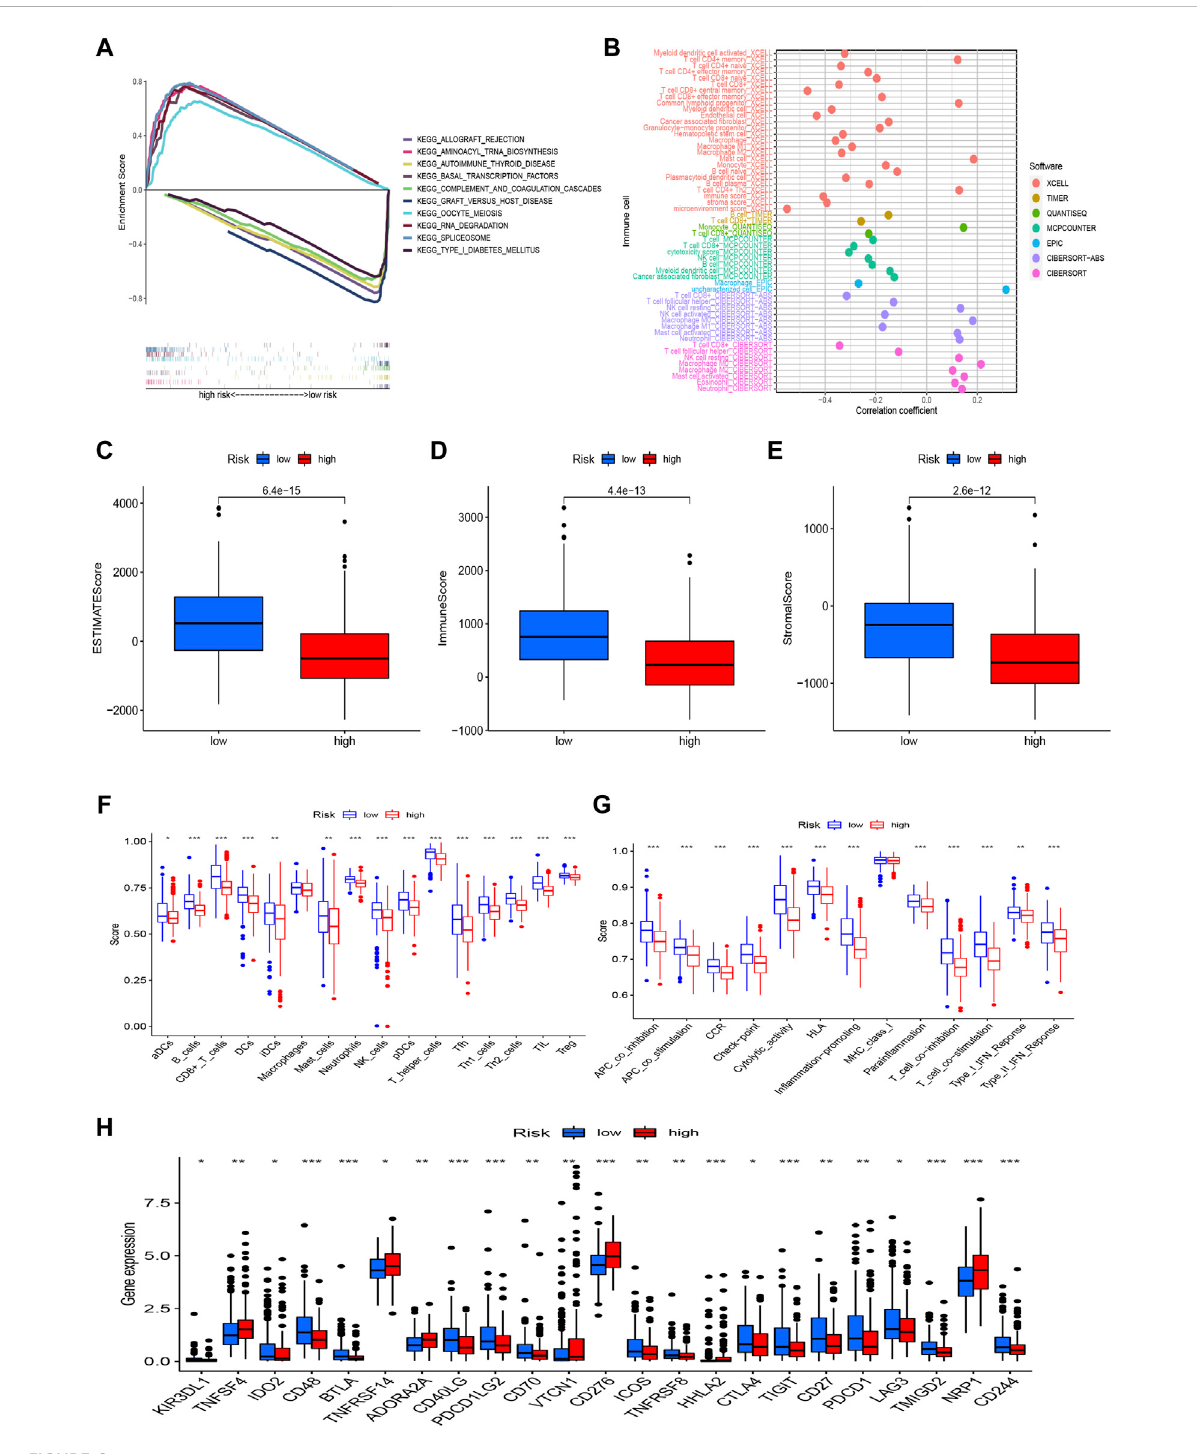
The differences of tumor immune microenvironment between the low-risk and high-risk groups. (A) GSEA of the top 10 pathways signi fi cantly enriched in the risk groups; (B) The immune cell bubble of risk groups; (C – E) The boxplots of the comparison of StromalScore, ImmuneScore, and ESTIMATEScore,respectively,betweenlow-andhigh-riskgroups; (F,G) ThessGSEAscoresofimmunecellsandimmunefunctionsintheriskgroups; (H) The difference of common immune checkpoint expression in the risk groups. * p < 0.05, ** p < 0.01, *** p <